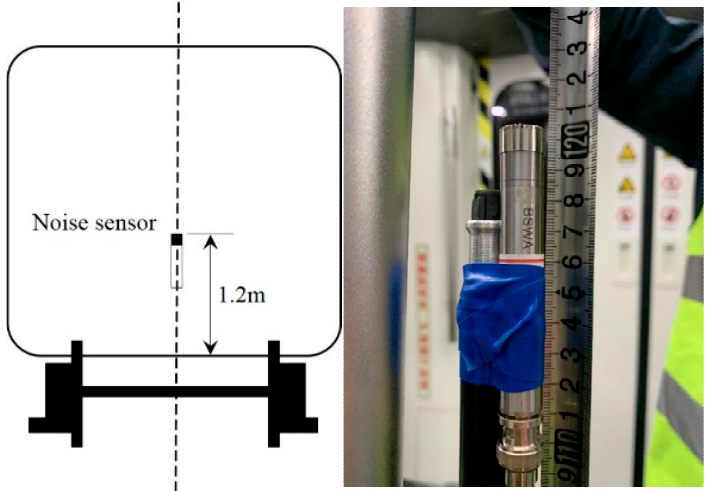
Figure 2. Noise sensor